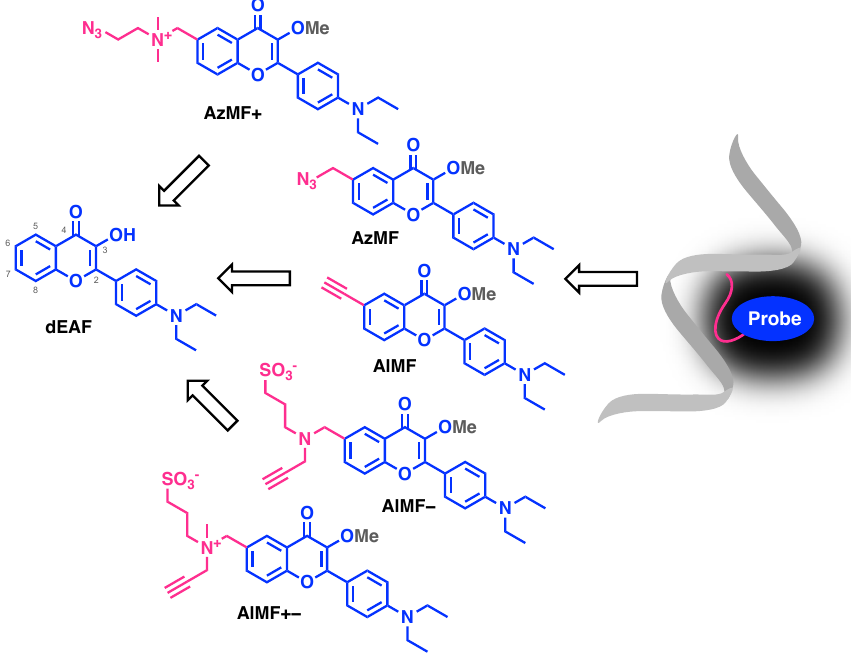
Scheme 1. Chemical structures of the parent chromone ( dEAF ) as well as the azido ( AzMF ) and alkynyl ( AlMF ) derivatives developed for click-type post-synthetic DNA labeling. Systematic flavonoid numbering was displayed on the original